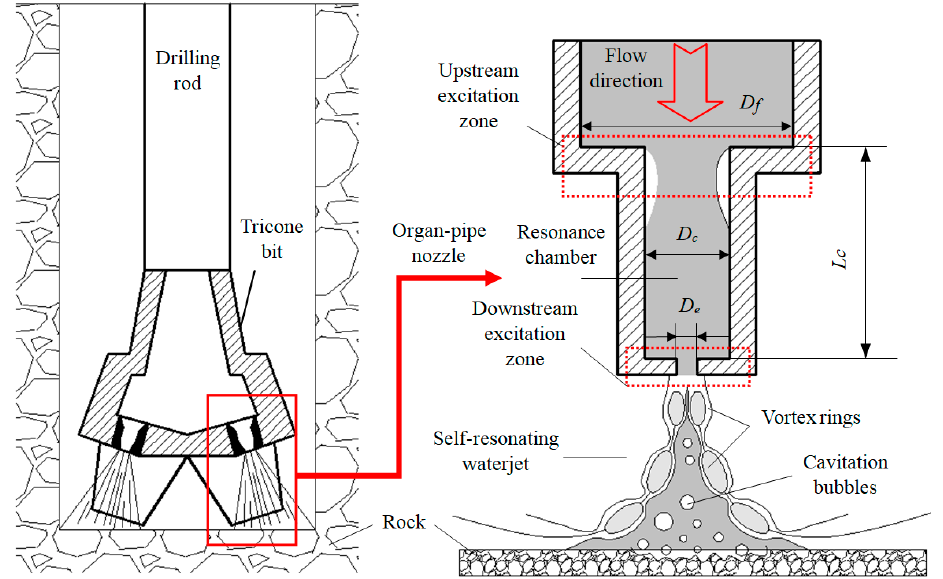
Figure 1. The schematic of the working principles and geometry of organ-pipe nozzles in deep-hole